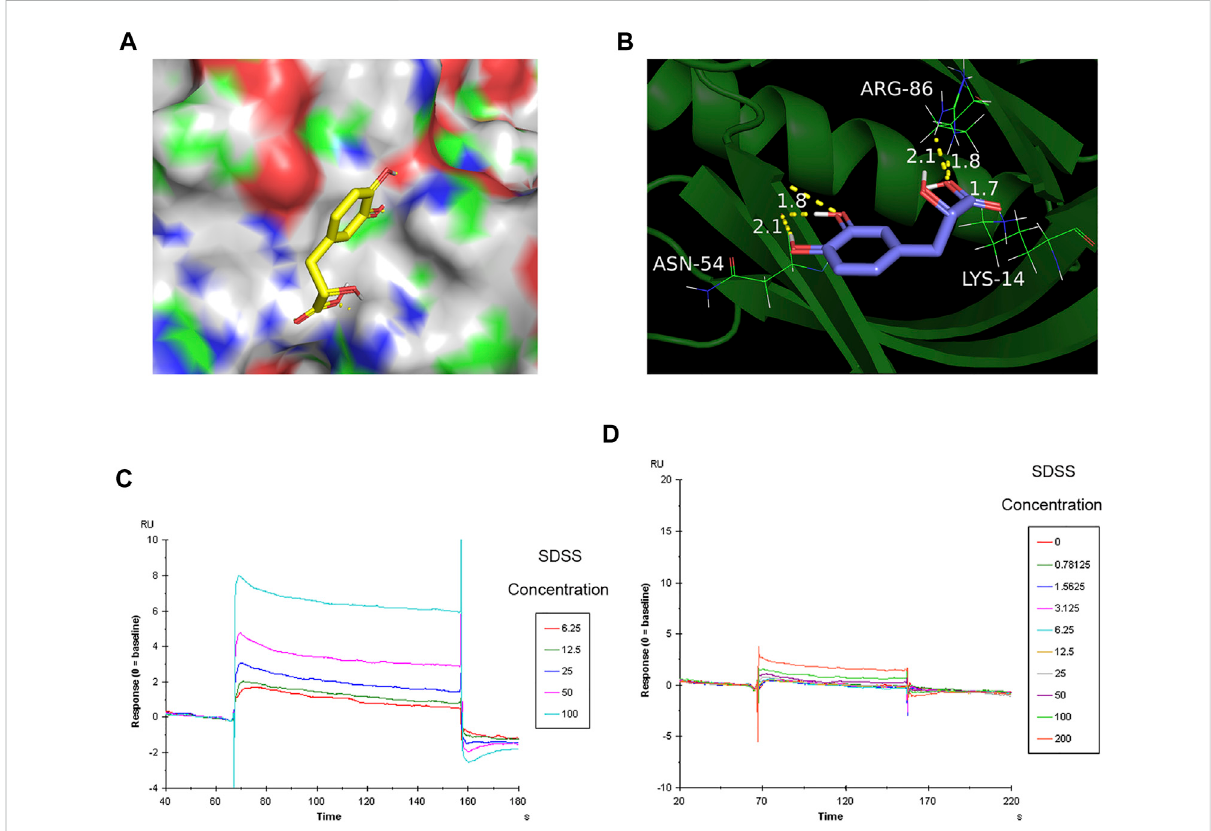
FIGURE 4 The binding sites of SDSS to AKT1 were predicted by Autodock and then veri fi ed by SPR. (A) The 3D structure of SDSS docked by the AKT1 PH domain.SDSSisshowninsticksmode; AKT1isshown incolorsurfacemode. (B) ThebindingsiteofSDSSwiththeAKT1PHdomain.SDSSisshownin sticks mode; AKT1 is shown in cartoon mode. Surface plasmon resonance (SPR) analysis showing a direct interaction between SDSS and wide-type AKT1 (C) or mutant AKT1 (D) . The Y-axis represents the response value between SDSS and proteins. The X-axis represents the reaction time between SDSS and proteins. The unit used for SDSS concentration was